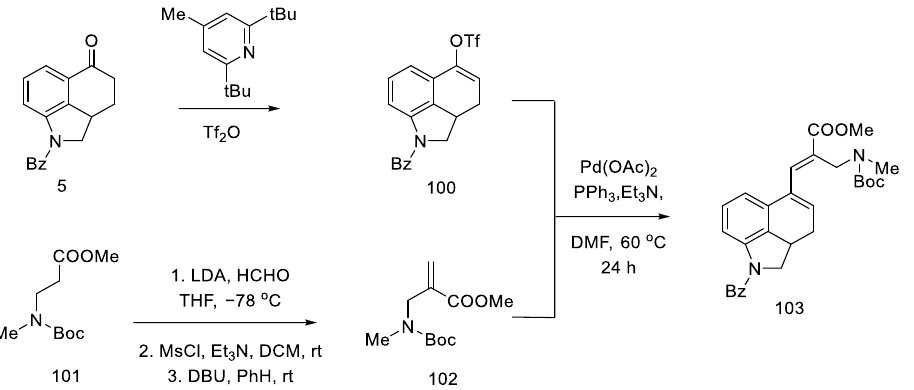
26 of 56 ring in the ergoline structure. A lot of synthetic work was based on the scheme: prepara- tion of halogen-indole or tryptophan derivatives, then coupling of the D-ring, manipula- tion of substituents to create favorable conditions for the intramolecular Heck reaction, and conversion of the functional groups to (+)-lysergic acid. 2.4.1. Ortar and Kurihara Groups Strategy of closing D-ring using the Heck method . In 1988, the Ortar group was the first to propose the preparation of lysergic acid through the palladium-catalyzed Heck coupling [79]. The starting material in the synthesis was Uhle’s ketone derivative 5 [31]. The tricyclic olefin 100 was obtained, as a substrate for the coupling reaction,